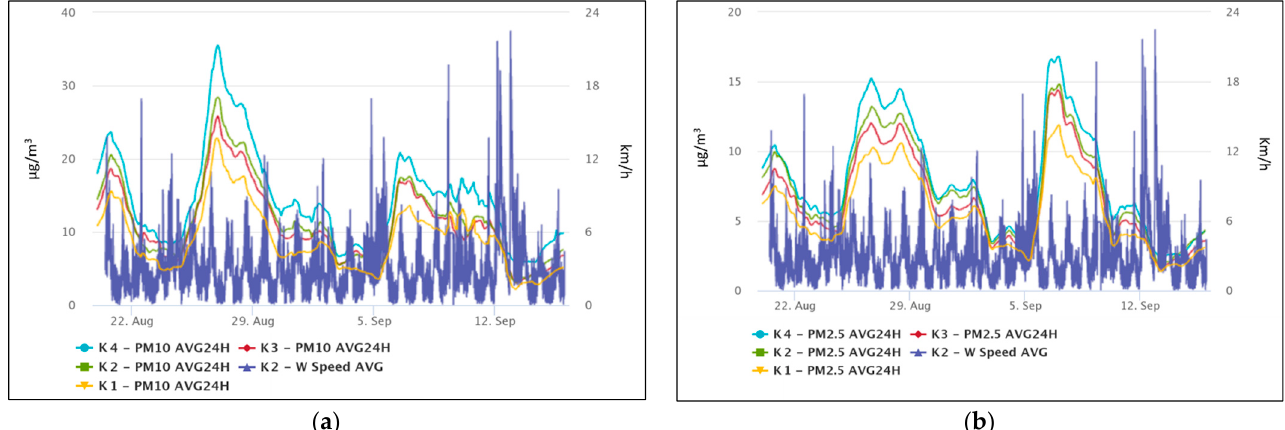
Figure 8. Average wind speed vs. PM 10 ( a ) and PM 2.5 ; ( b ) 24 h average over the experimental period 20 August–15 September 2022.